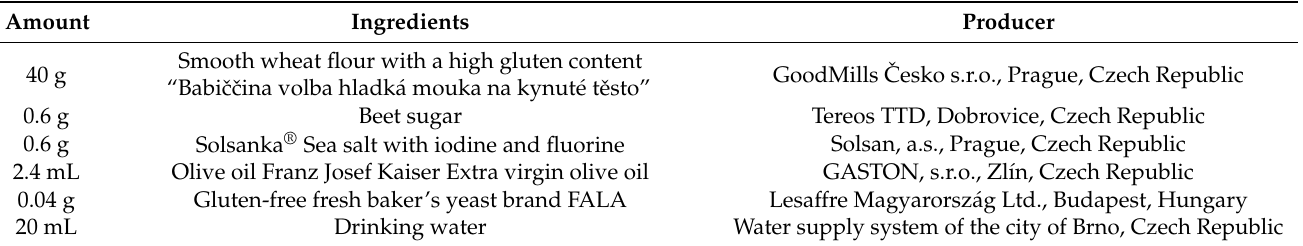
Table 2. Content of ingredients used to monitor the fermentation of a basic pizza dough.